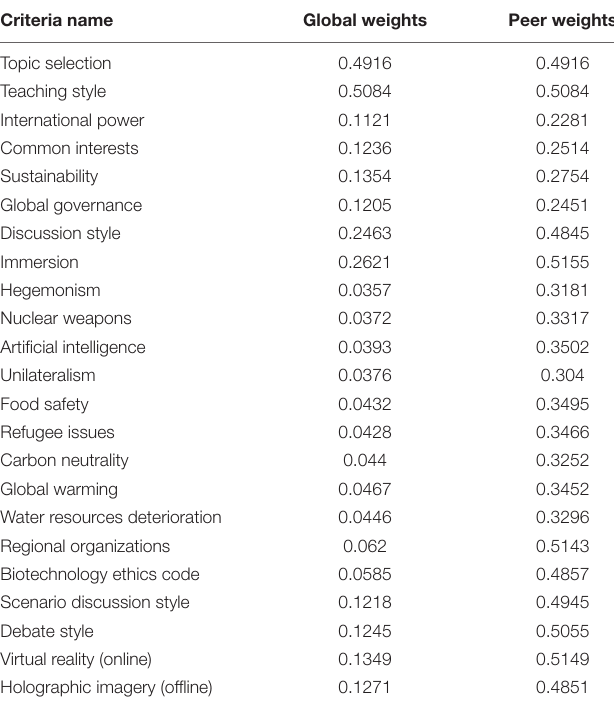
TABLE 3 | Weights table of education evaluation indicators with socioscientific issues